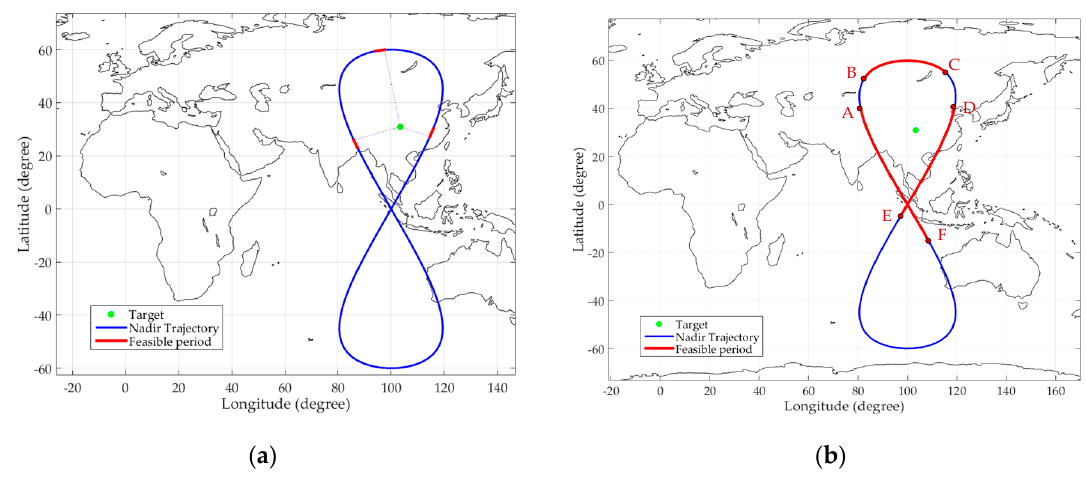
Figure 13. Comparison of GEO SAR observation durations obtained for a nadir trajectory mode ( a ) in broadside and ( b ) the proposed squint mode